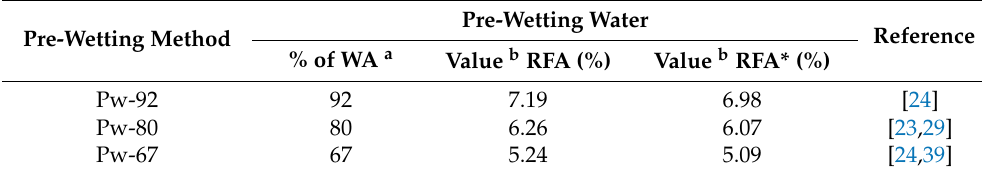
Table 3. Pre-wetting